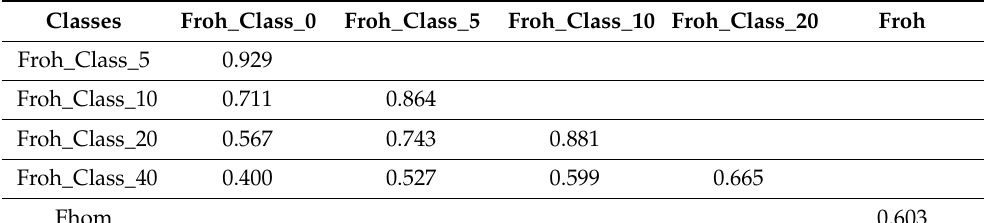
Figure 5. Inbreeding coefficient at a genomic level for all six breeds. Table 3. Correlations runs of homozygosity (ROH) between class category (0, 5, 10, 20, and >40 Mb), inbreeding coefficients in six different bulls.